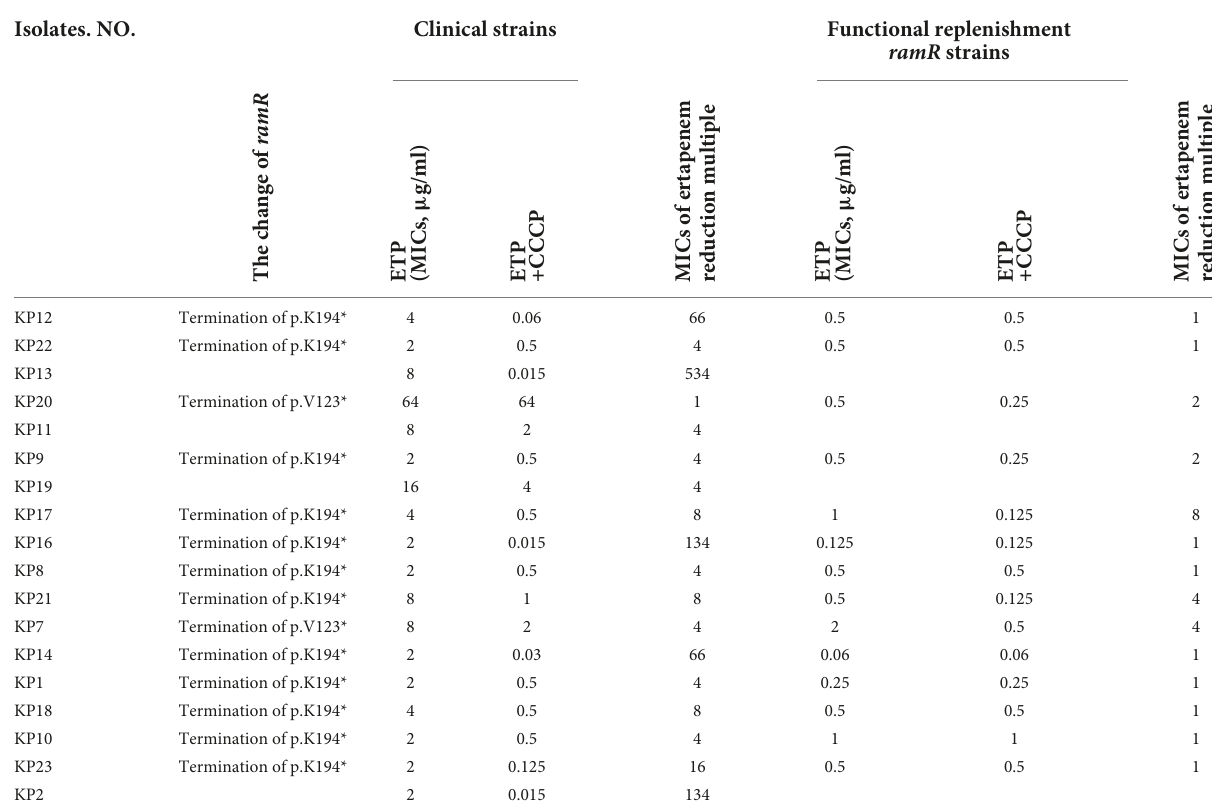
TABLE 3 Drug sensitivity of wild strain and clonal strain. Isolates. NO.